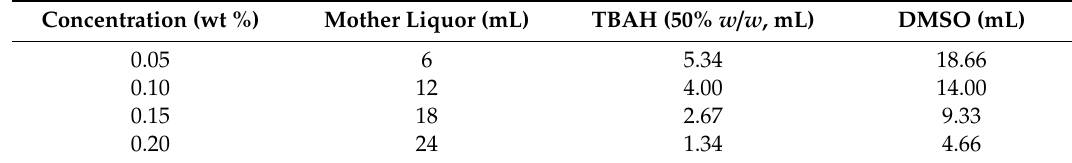
Table 1. Preparation of cellulose / THDS aqueous solutions by dilution